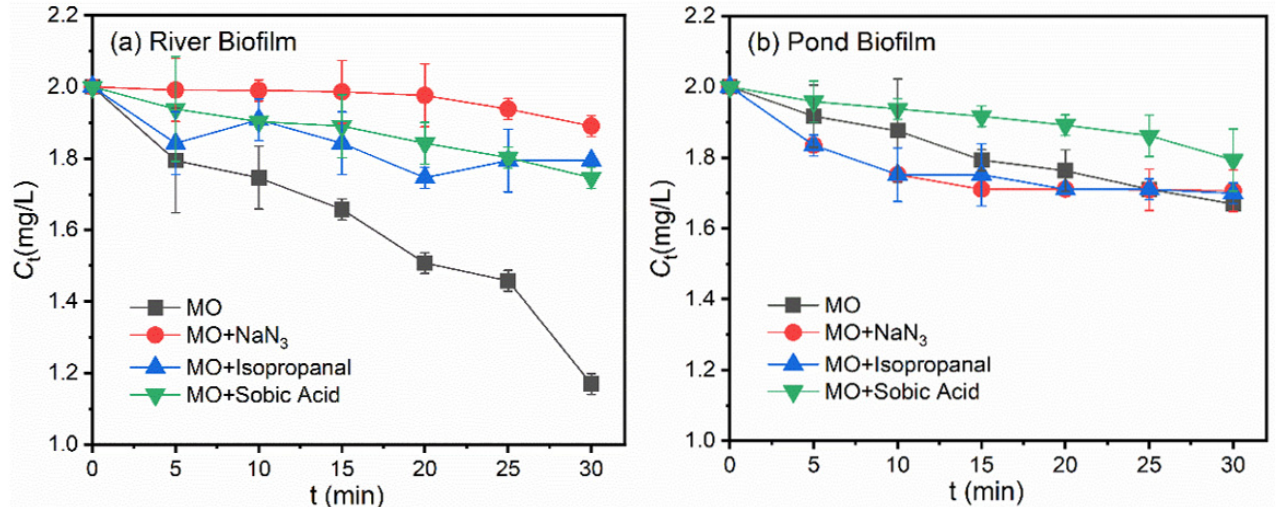
Figure 4. Photodegradation rate of MO with quenchers (isopropanol, NaN 3 and sorbic acid) in the presence of the suspensions derived from ( a ) River Biofilm and ( b ) Pond Biofilm. Experimental con- ditions: [MO] 0 =2 mg/L, [Biofilm] = 696 mg/L, pH = 6.8 (10 mM phosphate buffer).